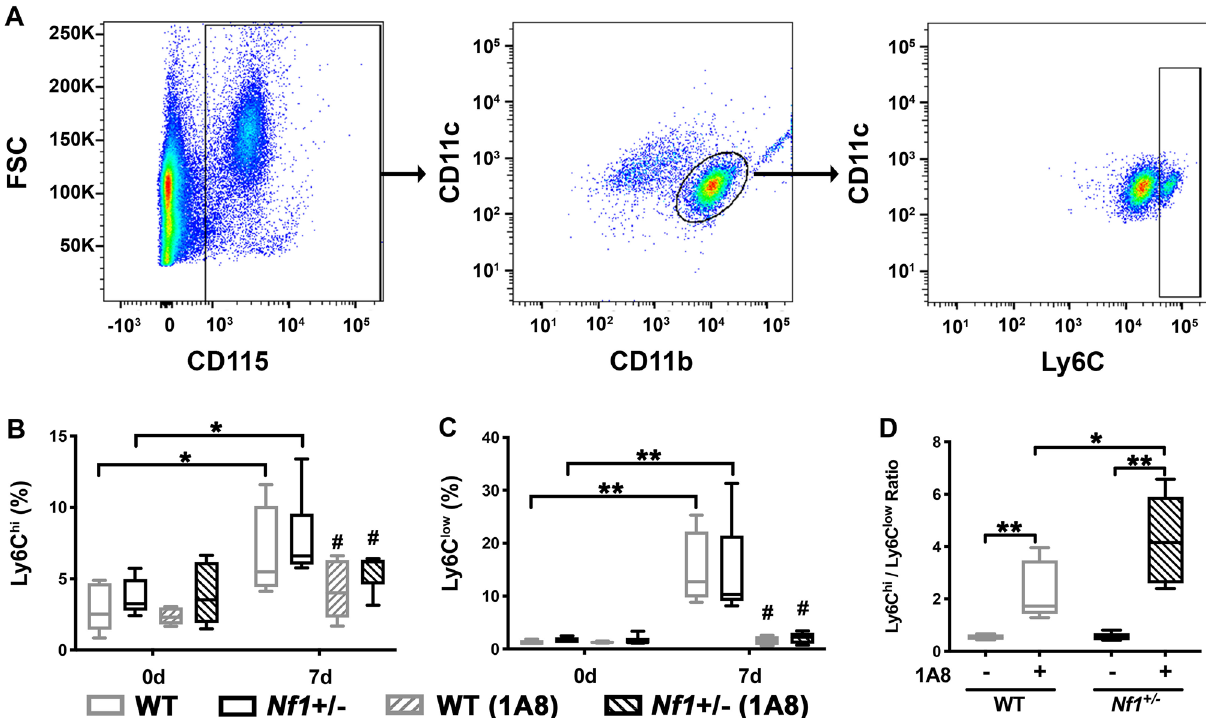
Figure 4. Early neutrophil depletion suppresses circulating Ly6C low monocyte frequency. ( A ) Representative gating strategy to identify Ly6C hi and Ly6C low monocytes. ( B–D ) Quantitation of circulating Ly6C hi ( B ), Ly6C low ( C ) and Ly6C hi /Ly6C low ratio ( D ) in WT (gray) and Nf1 +/– (black) mice provided non-specific IgG or monoclonal Ly6G antibody. Boxes represent the 25th and 75th percentile with median value designated by horizontal line within each box. Whiskers represent the minimum and maximum values. * P < 0.05 and ** P < 0.001 for each comparison. # P < 0.01 for WT and Nf1 +/– mice provided non-specific IgG versus WT and Nf1 +/– mice provided monoclonal Ly6G antibody. Analysis by 2-way